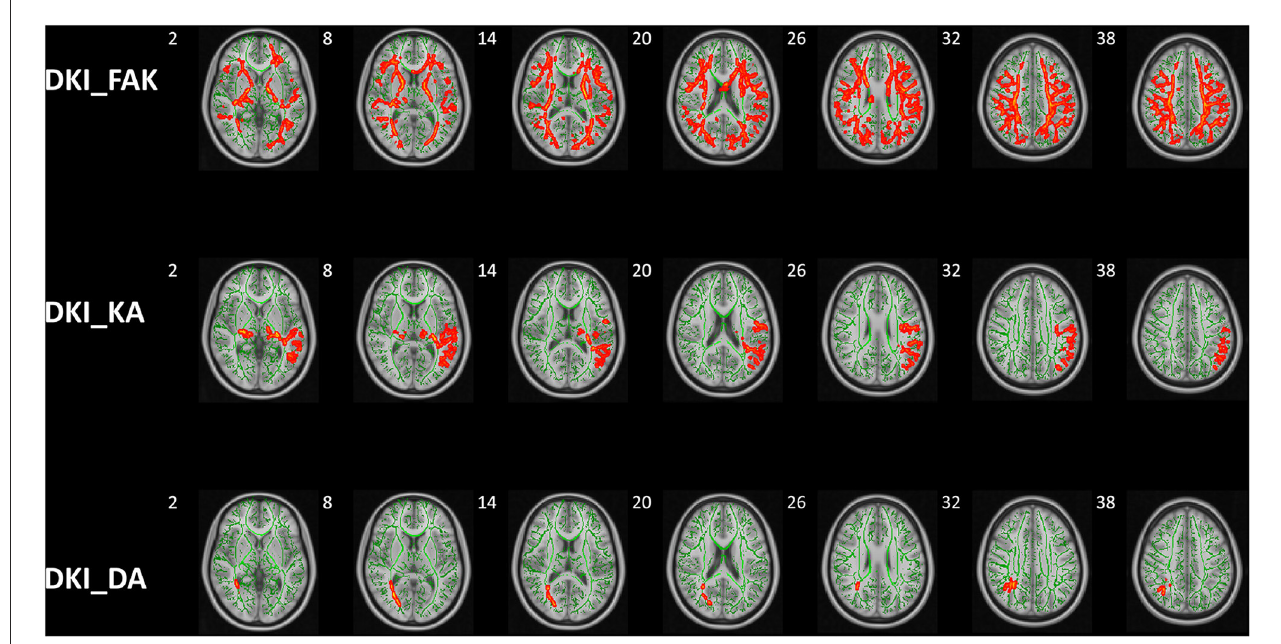
FIGURE4 Group differences of TBSS in FAK, KA, and DA. Tract-based spatial statistics shows white matter regions with significant ( p < 0.05, threshold-free cluster enhancement corrected) differences in FAK, KA, and DA values between ASD children and HCs. Green represents mean FA skeleton of all participants; red denotes parameters reduction in ASD children. DKI, diffusion kurtosis imaging; HCs, healthy controls; KFA, kurtosis FA; DA, axial diffusivity; KA, axial